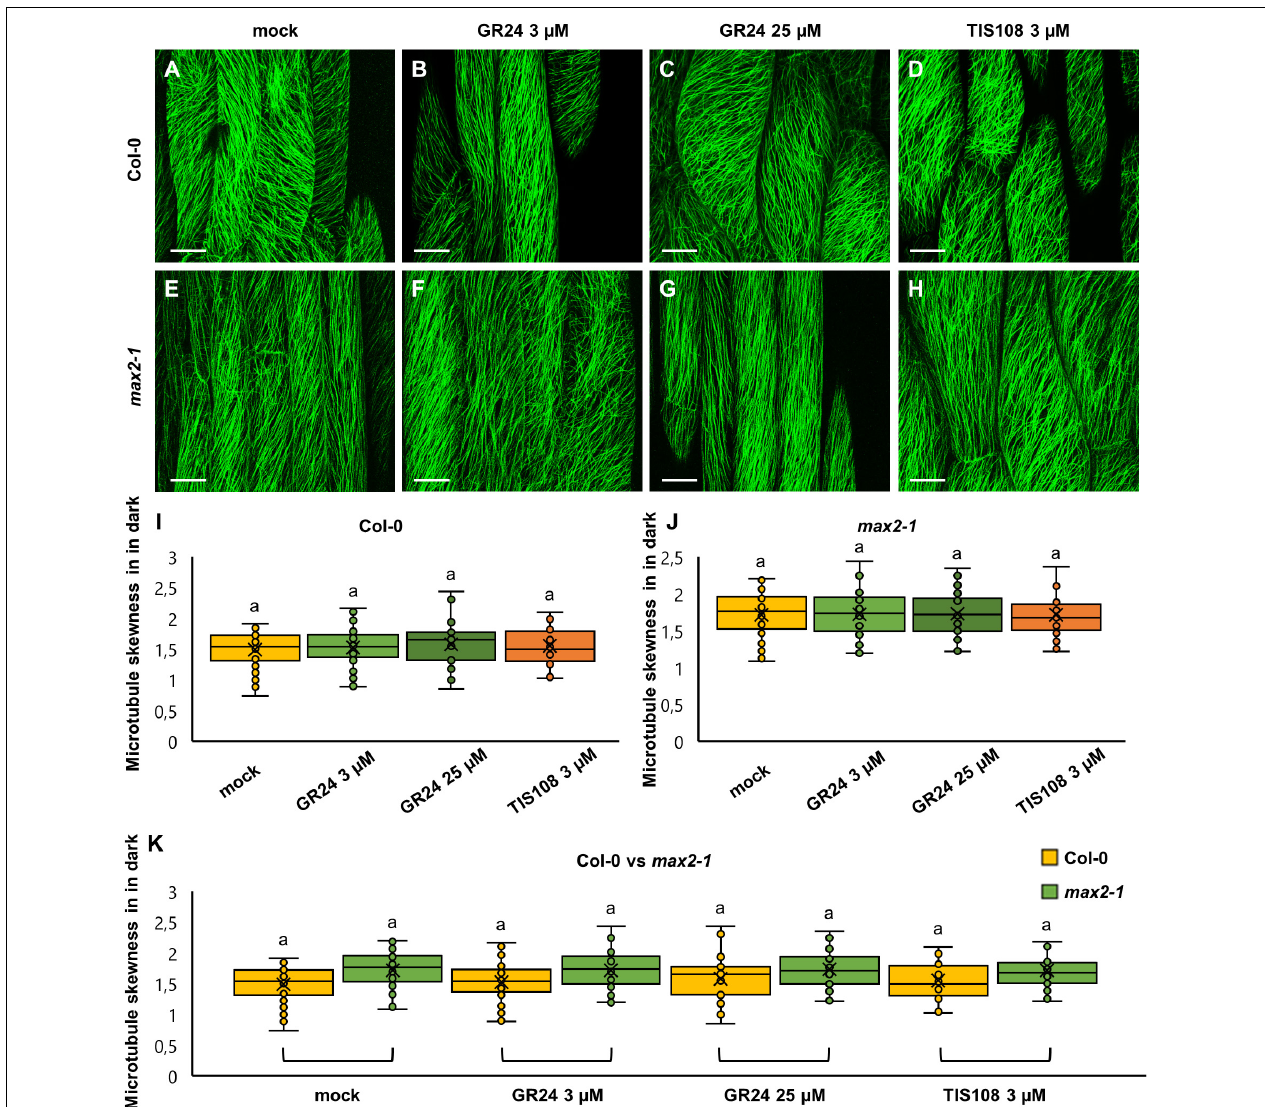
FIGURE 6 | The skewness of fluorescence distribution of GFP-MBD-labeled microtubules of etiolated Arabidopsis Col-0 and max2-1 epidermal hypocotyl cells in the presence or absence of the synthetic strigolactone GR24 (3 µ M and 25 µ M) or the biosynthetic inhibitor of strigolactone production TIS108 (3 µ M). (A–D) Overviews of hypocotyl of Col-0 seedlings treated with mock (A) , 3 µ M GR24 (B) , 25 µ M GR24 (C) , 3 µ M TIS108 (D) . (E–H) Overview of hypocotyl of max2-1 seedlings treated with mock (E) , 3 µ M GR24 (F) , 25 µ M GR24 (G) , 3 µ M TIS108 (H) . (I,J) Quantitative assessment of fluorescence distribution skewness comparing Col-0 [ (I) ; N ≥ 22; Welch’s ANOVA showed no statistically significant difference within the dataset; F (3, 161) = 0.4564, p = 0.7138] and max2-1 [ (J) ; N ≥ 31; Welch’s ANOVA showed no statistically significant difference within the dataset; F (3, 151) = 0.0161, p = 0.9972]. (K) Collective quantification of fluorescence skewness comparing Col-0 and max2-1 in a pairwise manner in all experimental conditions ( N ≥ 22; two-way ANOVA was followed with Scheffé’s test, but there was no statistically significant difference at the 0.001 probability level; results are in Supplementary Table 9 ). In all box plots, the average is presented by × , median by the middle line, 1 st quartile by the bottom line, 3 rd quartile by the top line; the whiskers lie within the 1.5 × interquartile range (defined from the 1 st to the 3 rd quartiles) while outliers are omitted. Scale bars: 20 µ m.